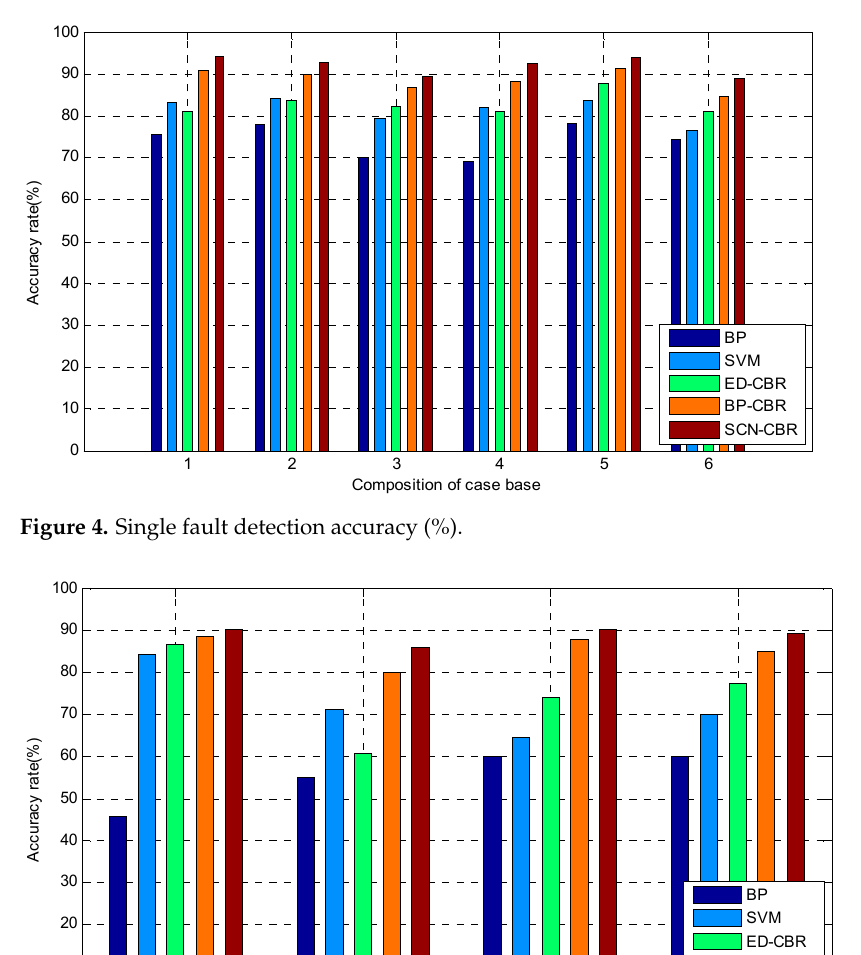
Figure 6. The running time of different methods for steam-water system fault detection ( s ).